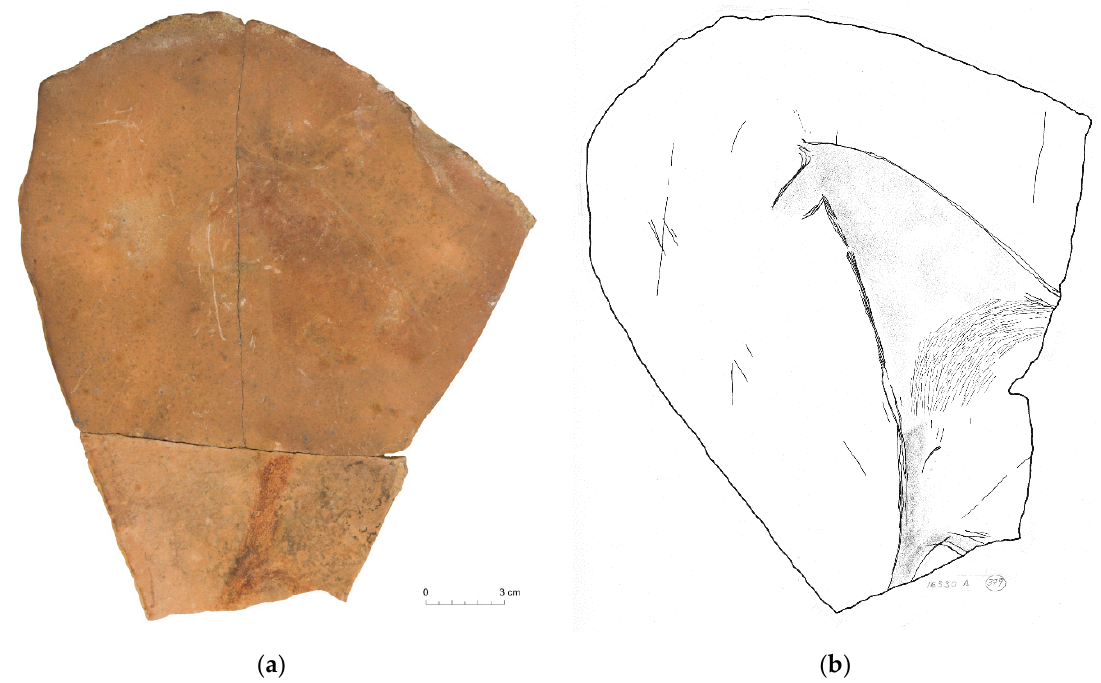
Figure 1. Plaquette 16330A: ( a ) orthophotomosaic (see Section 4); ( b ) scanned image of the original tracing of plaquette 16330A published by Villaverde in 1994 (see Section 4.1.3).